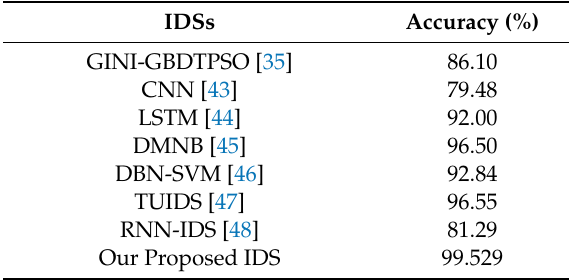
Table 4. The comparison accuracy on the NSL-KDD dataset.